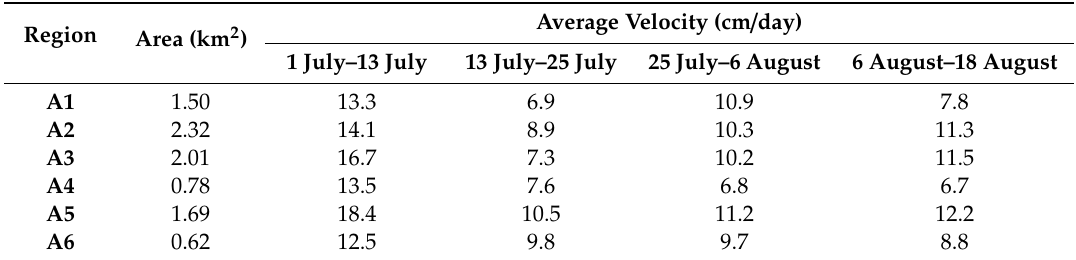
Average Velocity (cm /